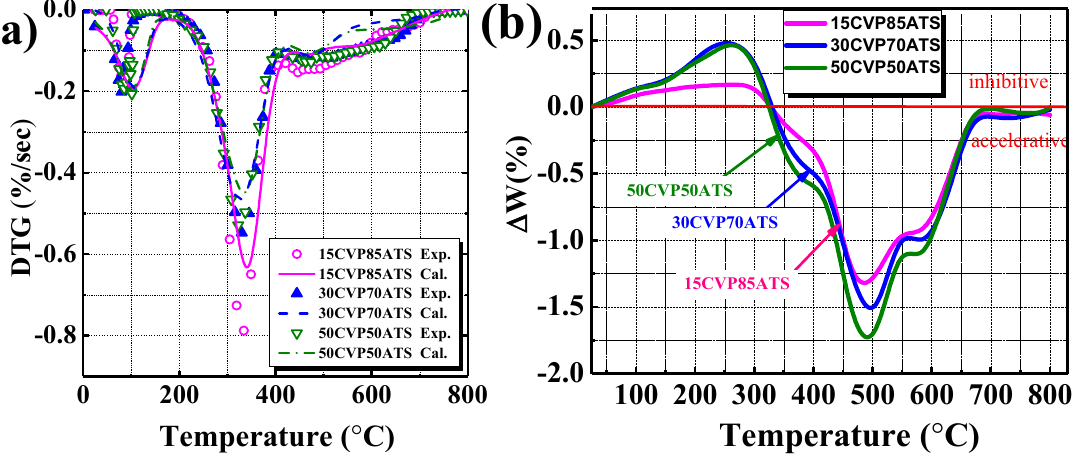
Figure 10. ( a ) Experiment and calculation DTG curve, and ( b ) variation profiles of Δ W (TG) of different CSBs ( β = 30 °C /min).